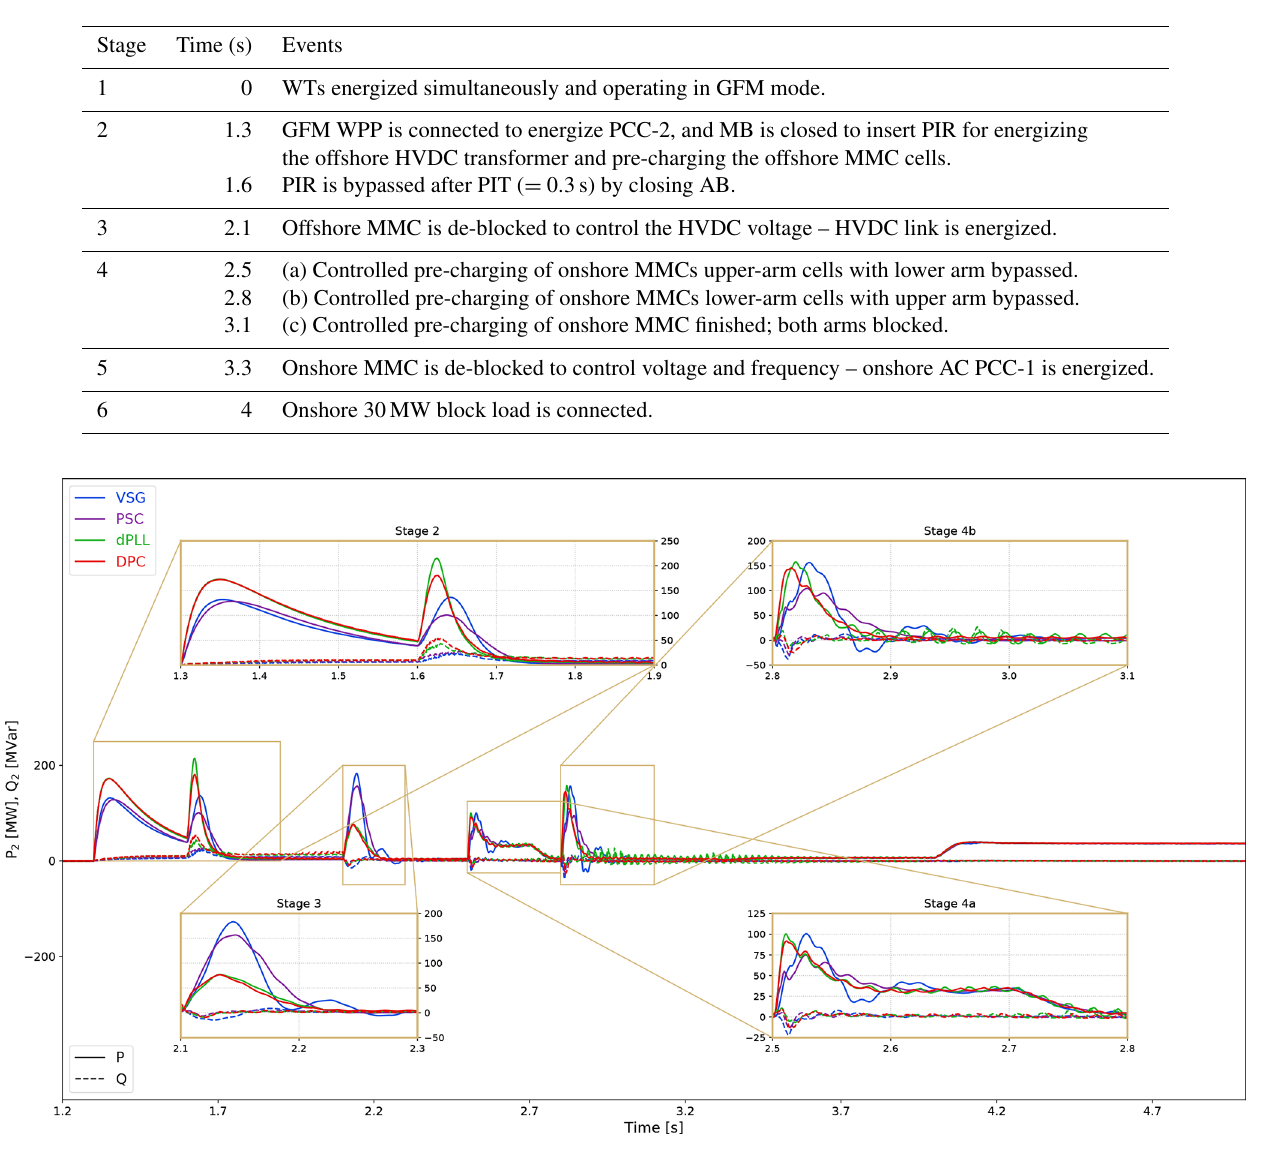
Figure 4. Real (solid line) and reactive (dotted line) power output of the offshore WPP with zoomed insets to show transients in selected stages of the energization